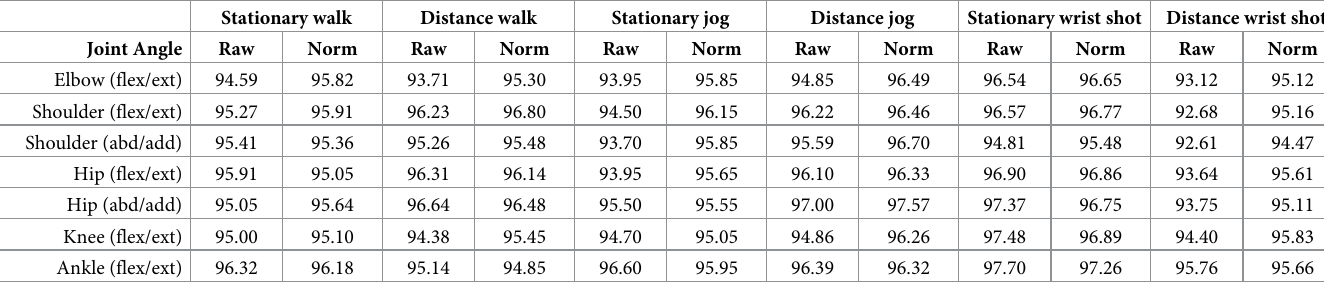
Table 7. LOA (%) comparison between PNS and VICON for raw and normalized values for all movements. Stationary walk